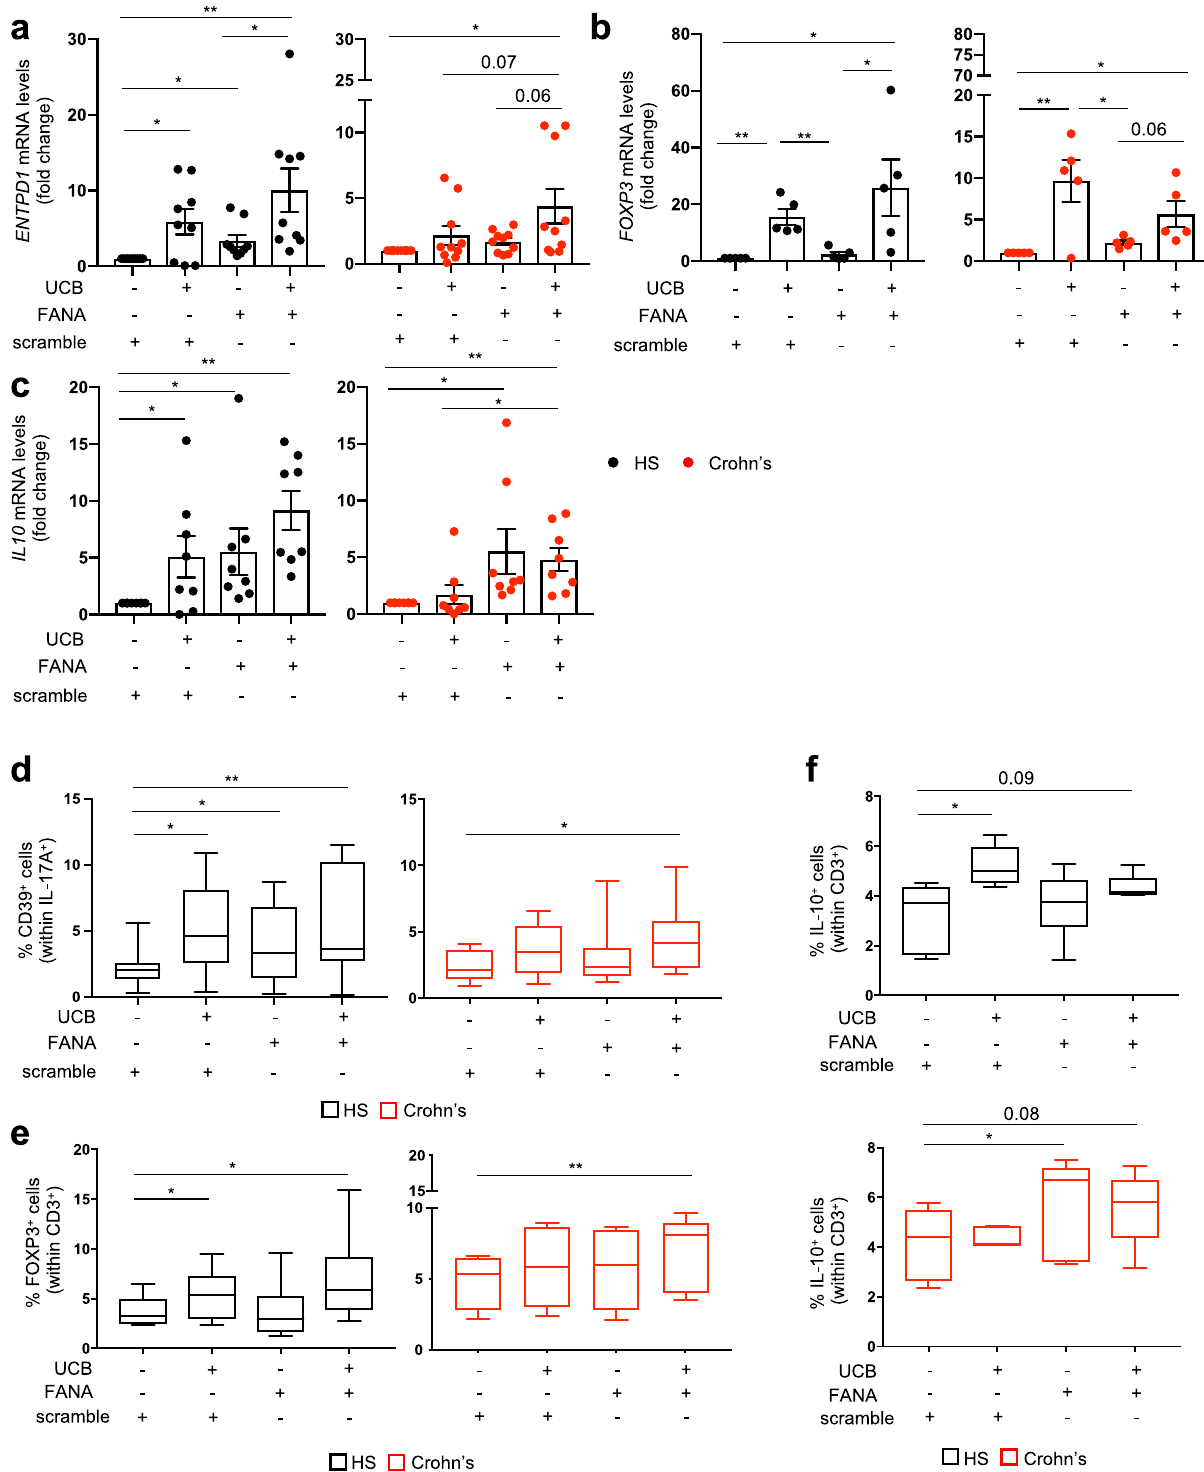
Fig. 5 Silencing of PGK1 and ALDOA boosts UCB immunoregulatory properties in Th17 cells derived from Crohn ’ s disease patients. Peripheral blood derived Th17 cells were exposed to FANA oligonucleotides, speci fi cally silencing PGK1 or ALDOA , alone or in combination with unconjugated bilirubin (UCB). Mean ± SEM ‘ a ’ ENTPD1 (encoding for CD39), ‘ b ’ FOXP3 , and ‘ c ’ IL10 mRNA levels in Th17 cells exposed to scramble, UCB, FANA oligonucleotides or FANA oligonucleotides plus UCB in healthy subjects (HS, n = 9 in a , n = 5 in b , and n = 8 in c ) and Crohn ’ s disease patients ( n = 10 in a , n = 5 in b , and n = 8 in c ). * P ≤ 0.05 and ** P ≤ 0.01 using ANOVA repeated measures followed by Tukey ’ s multiple comparison test. Results obtained in the presence of FANA- PGK1 and FANA- ALDOA are pooled. Box-and-whisker plots representing the frequency of ( d ) CD39 + (% of IL-17A + ), ( e ) FOXP3 + (% of CD3 + ), and ( f ) IL-10 + (% of CD3 + ) lymphocytes in polarized Th17 cells exposed to scramble, UCB, FANA oligonucleotides or FANA oligonucleotides plus UCB (HS, n = 12 in d and n = 6 in e , f Crohn ’ s disease patients, n = 10 in d and n = 5 in e , f ). Results obtained in the presence of FANA- PGK1 or FANA- ALDOA are pooled. * P ≤ 0.05 and ** P ≤ 0.01 using ANOVA repeated measures followed by Tukey ’ s multiple comparison